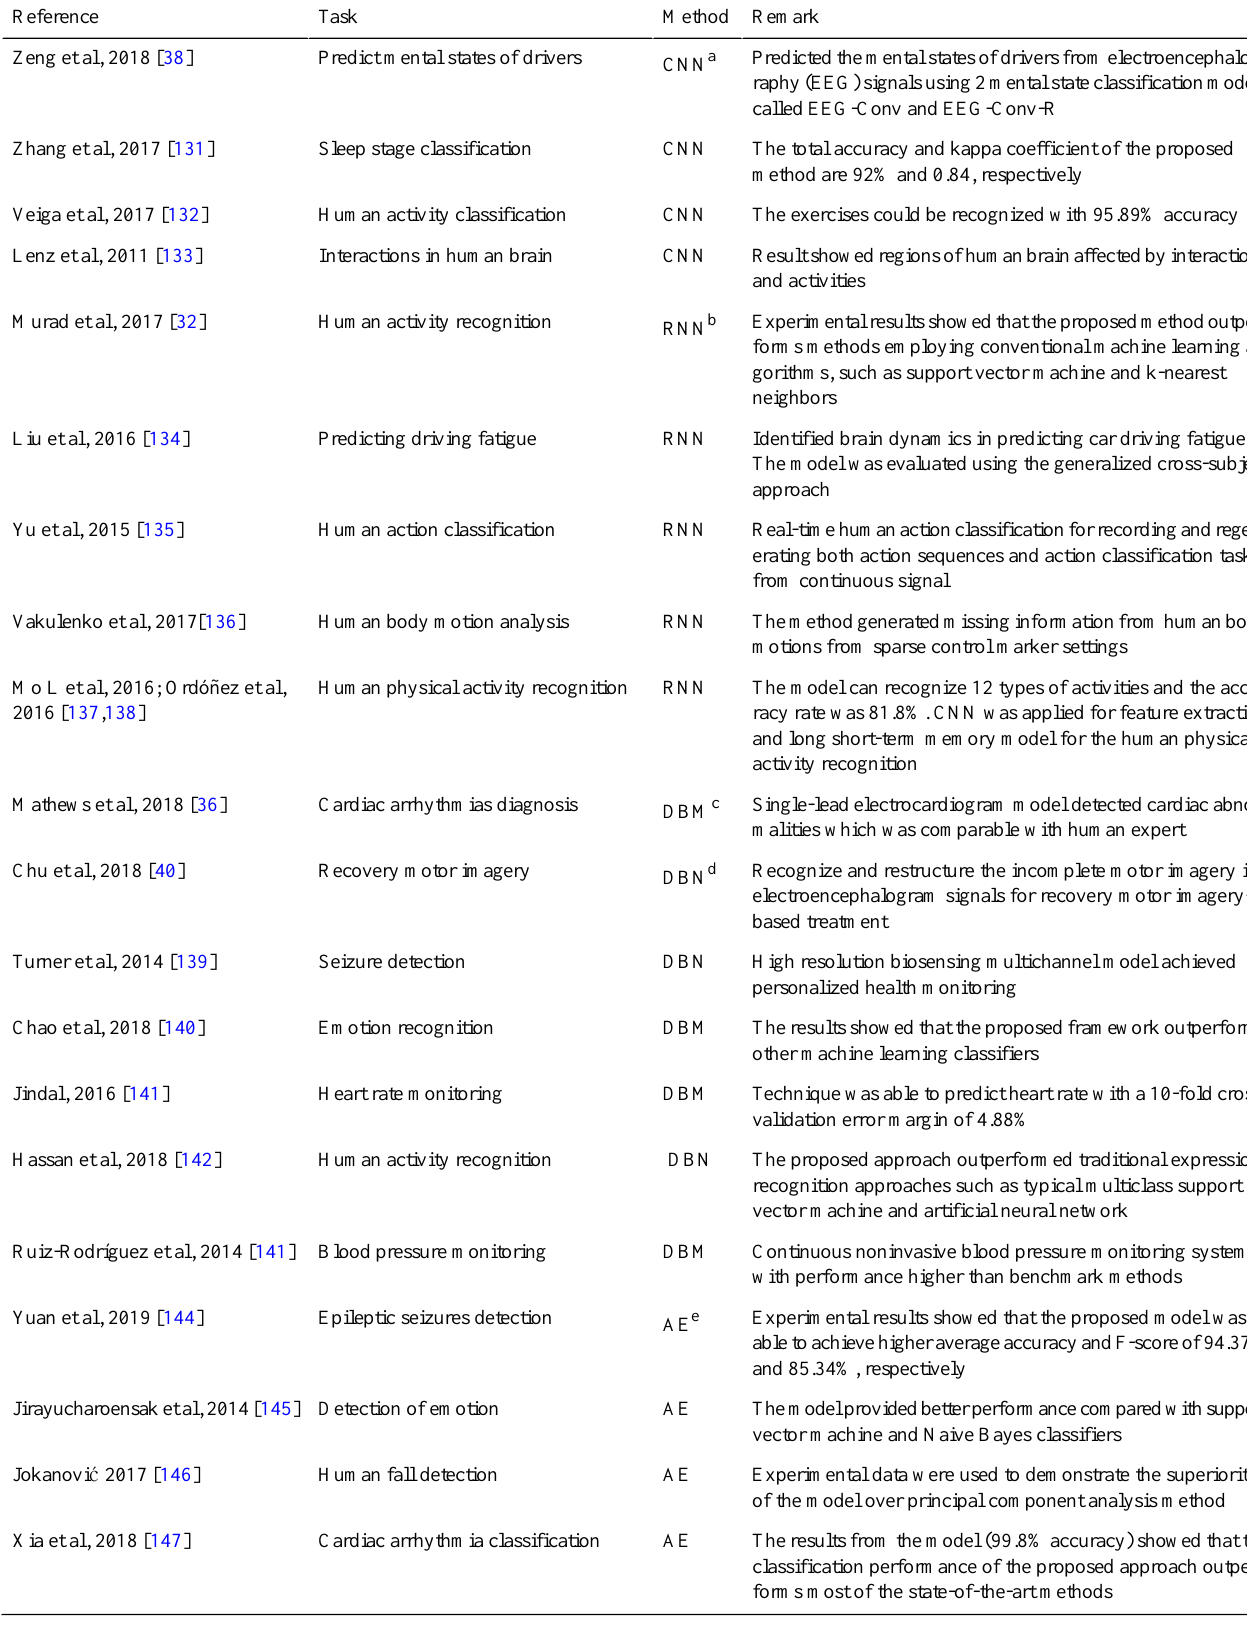
Table 4. Deep learning technique for sensors and physiological signal